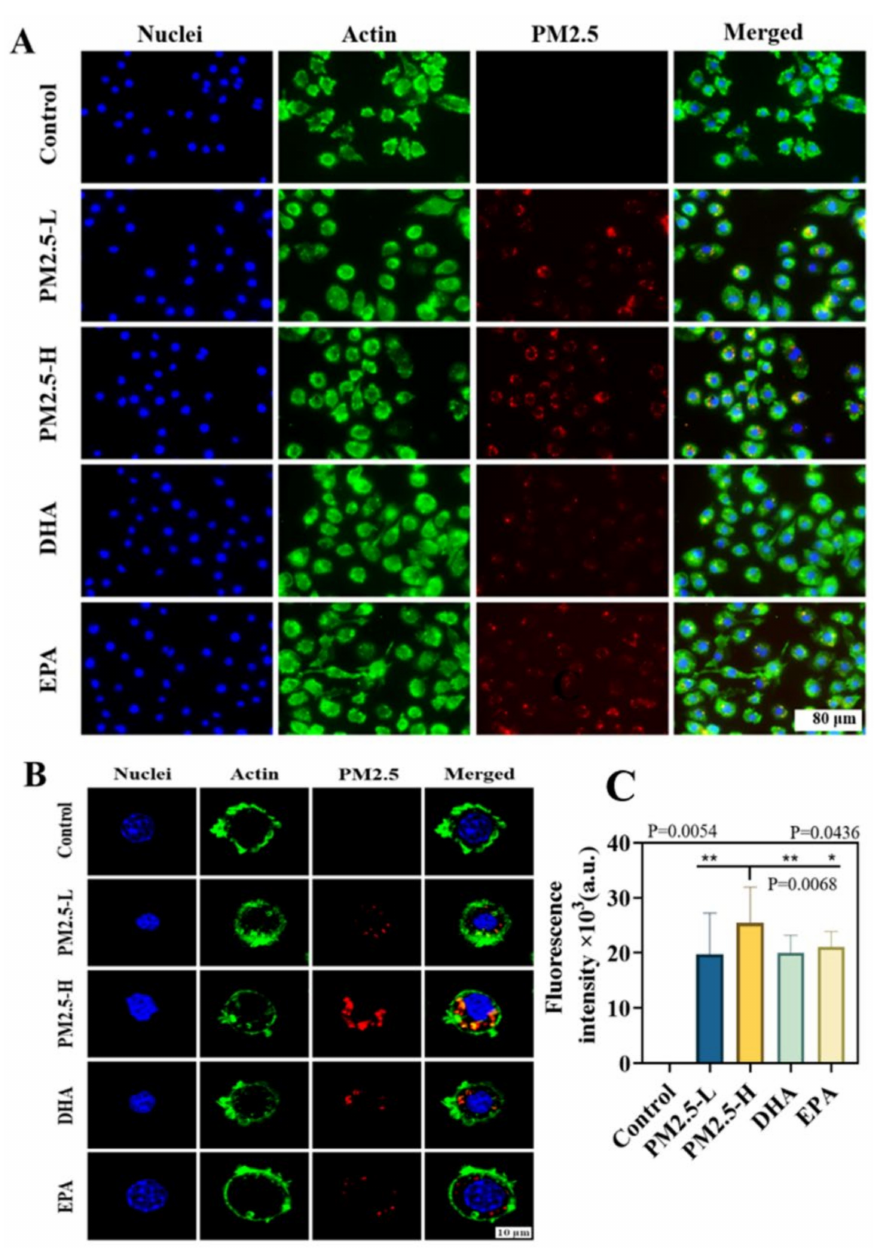
Figure 1. In vitro uptake studies. ( A ) Uptake of 100 µ g/mL (PM2.5-L) and 200 µ g/mL (PM2.5-H) PM2.5-Cy7 in RAW264.7 cells treated with 5 µ g/mL DHA and EPA for 4 h. ( B ) Phagocytosis of PM2.5-Cy7 in RAW264.7 cell was observed by confocal laser scanning microscopy (CLSM). ( C ) The quantification of fluorescence intensity of PM2.5-Cy7 in ( A ). Data are expressed as mean ± SD. * p < 0.11, ** p <